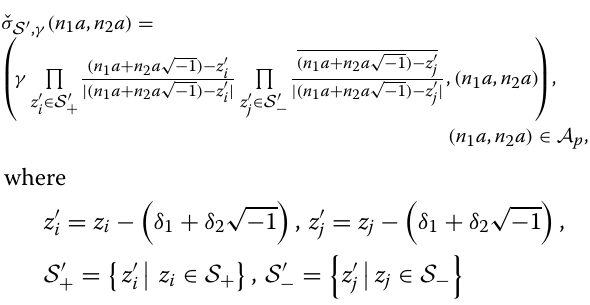
A parallel multi-screw dislocation is described as fol- lows. Let us define the section ˇ σ S (cid:8) , γ ∈ (cid:2)( A p , S 1 A